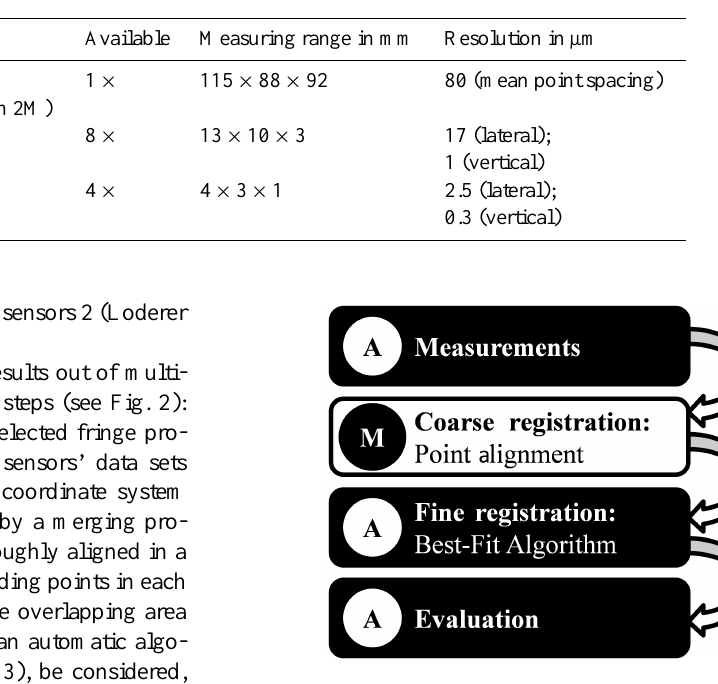
Figure 1. Technical sketch of the idea without an overview sensor (left side) and realized set-up of the prototypical multi-scale multi-sensor fringe projection system (right side). Table 1. Technical specifications of the fringe projection sensors.